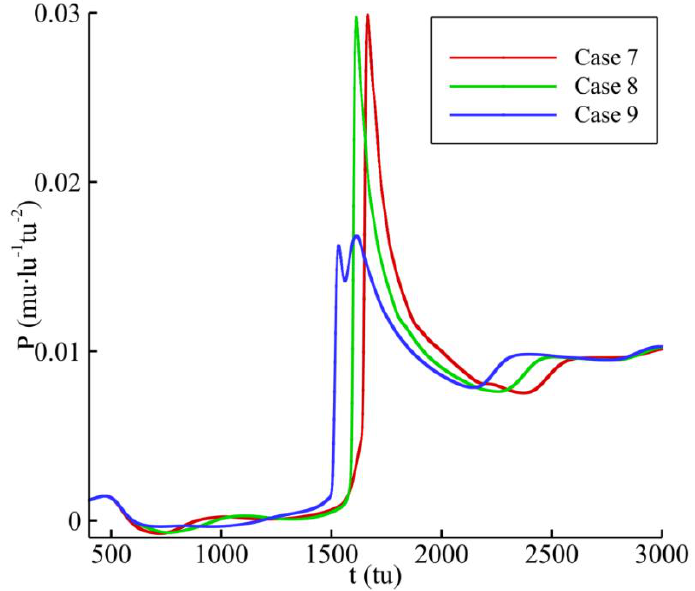
Figure 14. The evolution of pressure at point P in Cases 7–9.